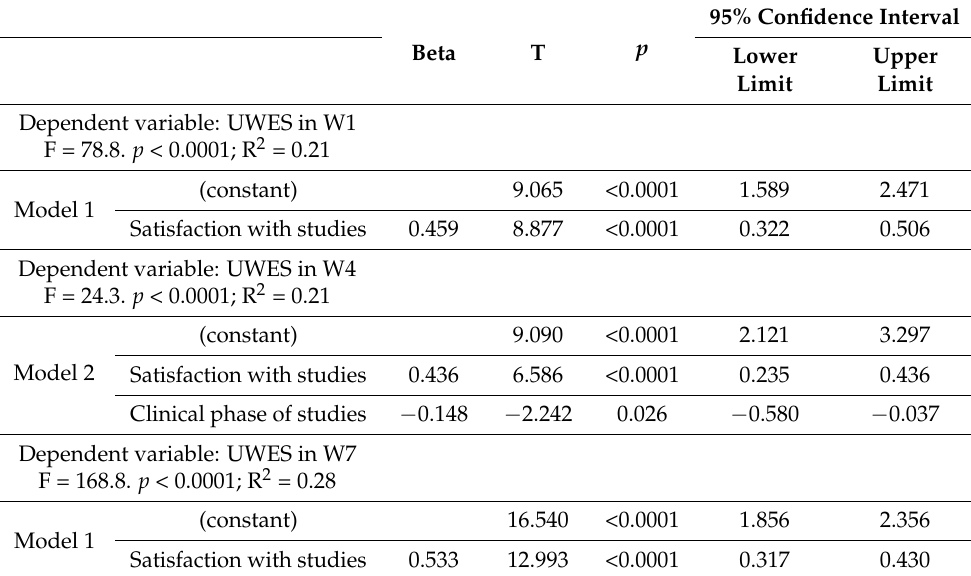
Table 7. Predictors of students’ work engagement (stepwise regression